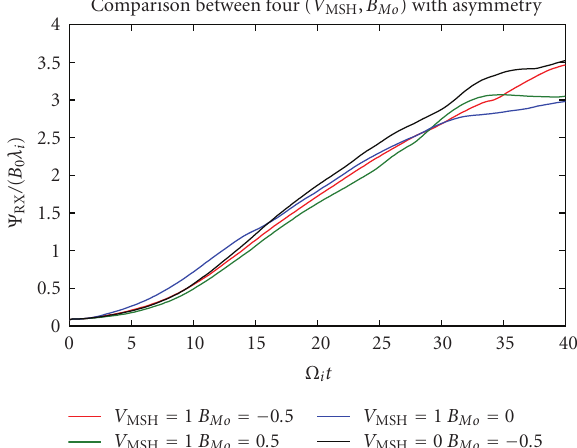
Figure 16: Growth curves of reconnection flux from various sets of ( V MSH , B Mo ). There is little di ff erence within the ( V MSH , B Mo ) range